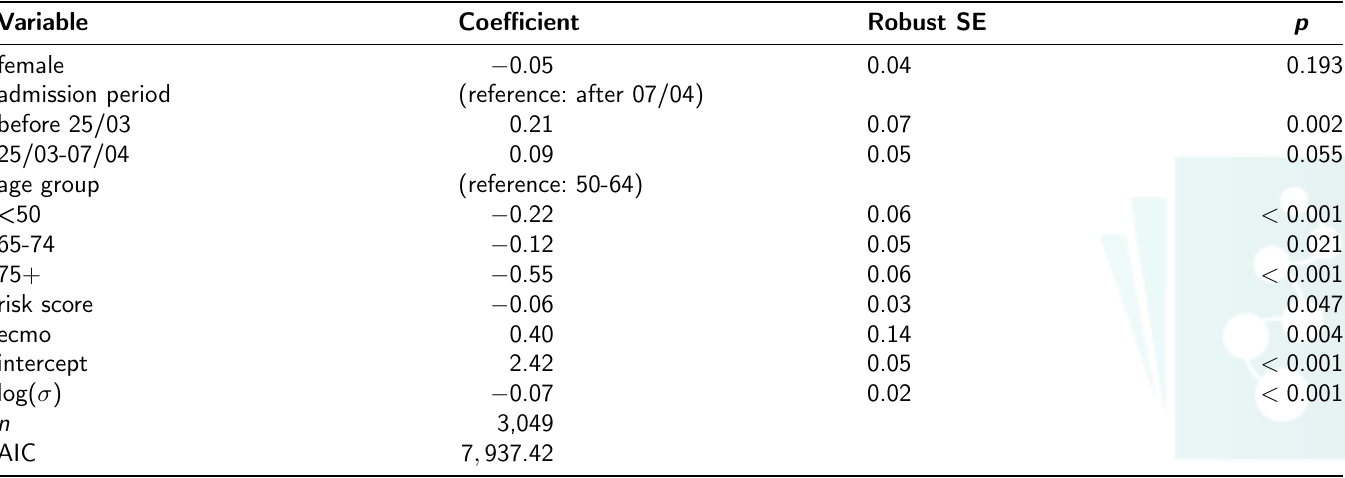
Table 2: Log-normal Accelerated Failure Time model with main effects